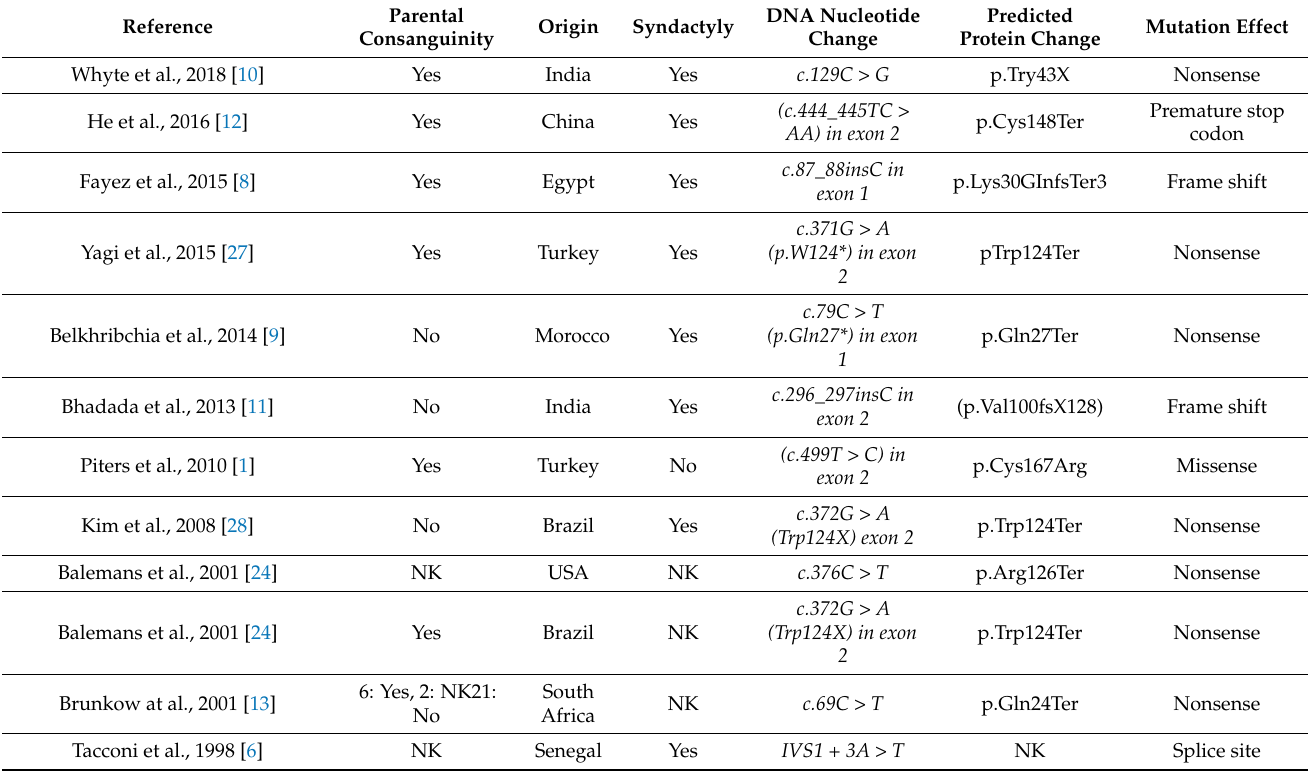
Table 1. The reported mutations in SOST gene leading to